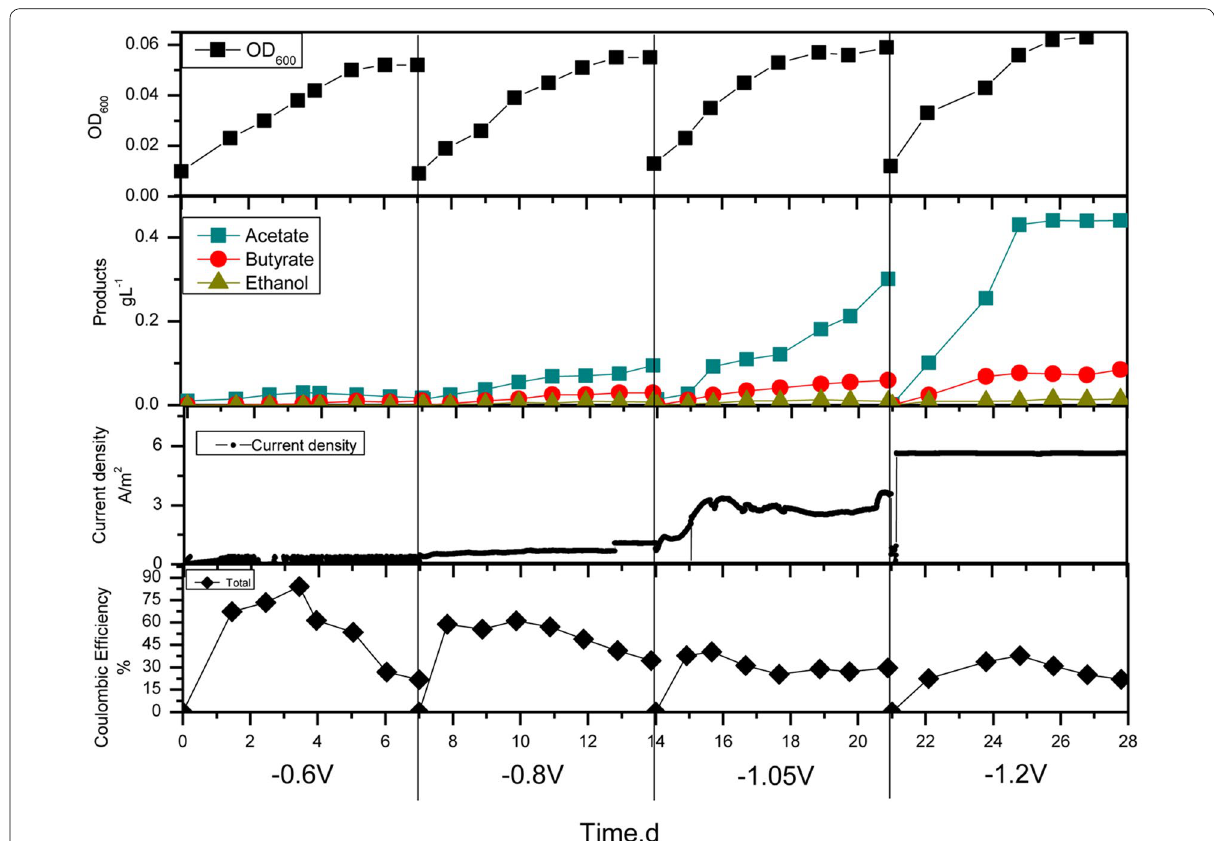
Fig. 2 Microbial electrosynthesis experiments of C. scatologenes ATCC 25775 at different potentials: ( a ) OD 600 of C. scatologenes ATCC 25775 at four different potentials ( b ) product formation by C. scatologenes ATCC 25775 at four different potentials ( c ) current density of C. scatologenes ATCC 25775 at four different potentials ( d ) coulombic efficiency of C. scatologenes ATCC 25775 at four different